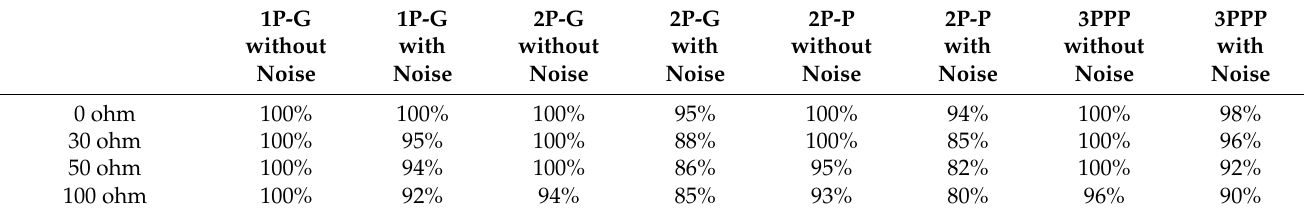
Table 4. Accuracy rates according to fault resistance